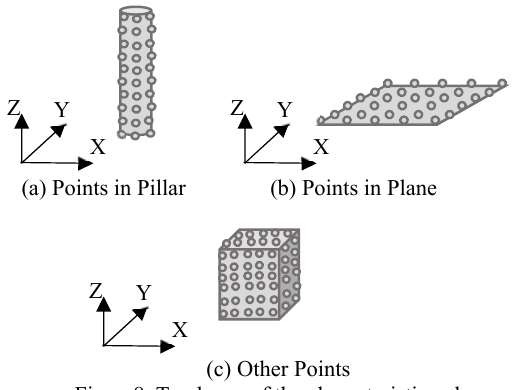
Figure8. Tendency of the characteristic value